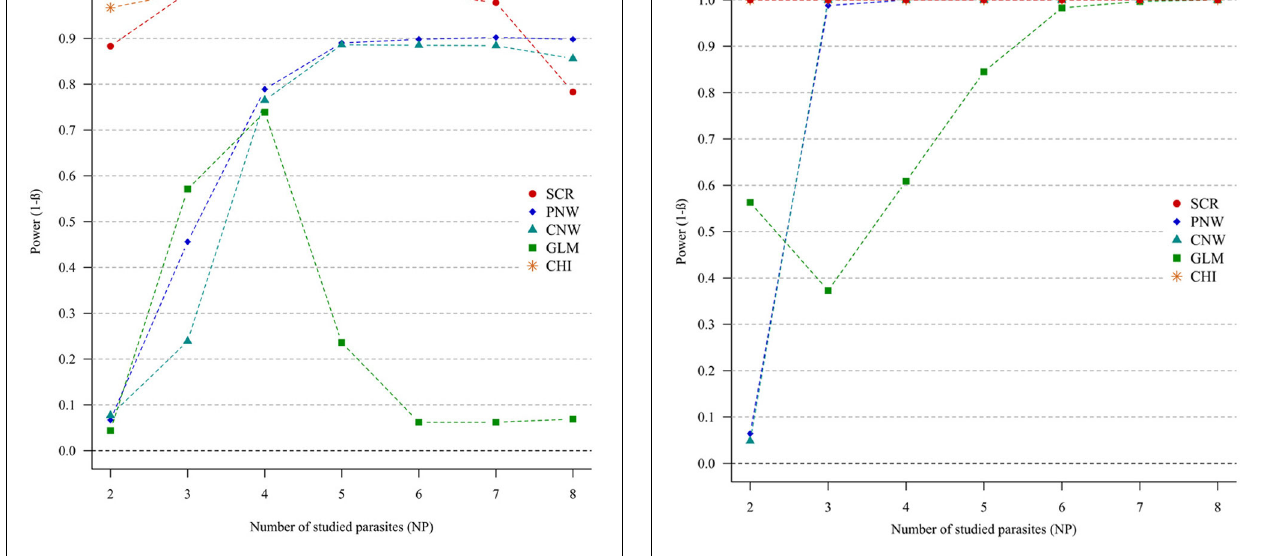
FIGURE 4 | Simulation outputs relative to the test of power (1- β ) for the four approaches used to detect parasite structuring, with strong positive correlations. CHI, generalized chi-square test; PNW, parasite network model; CNW, combination network model; GLM, multinomial GLM model and SCR, the association screening approach. The number of parasites varied from two to eight and the size of the total host population was fixed to